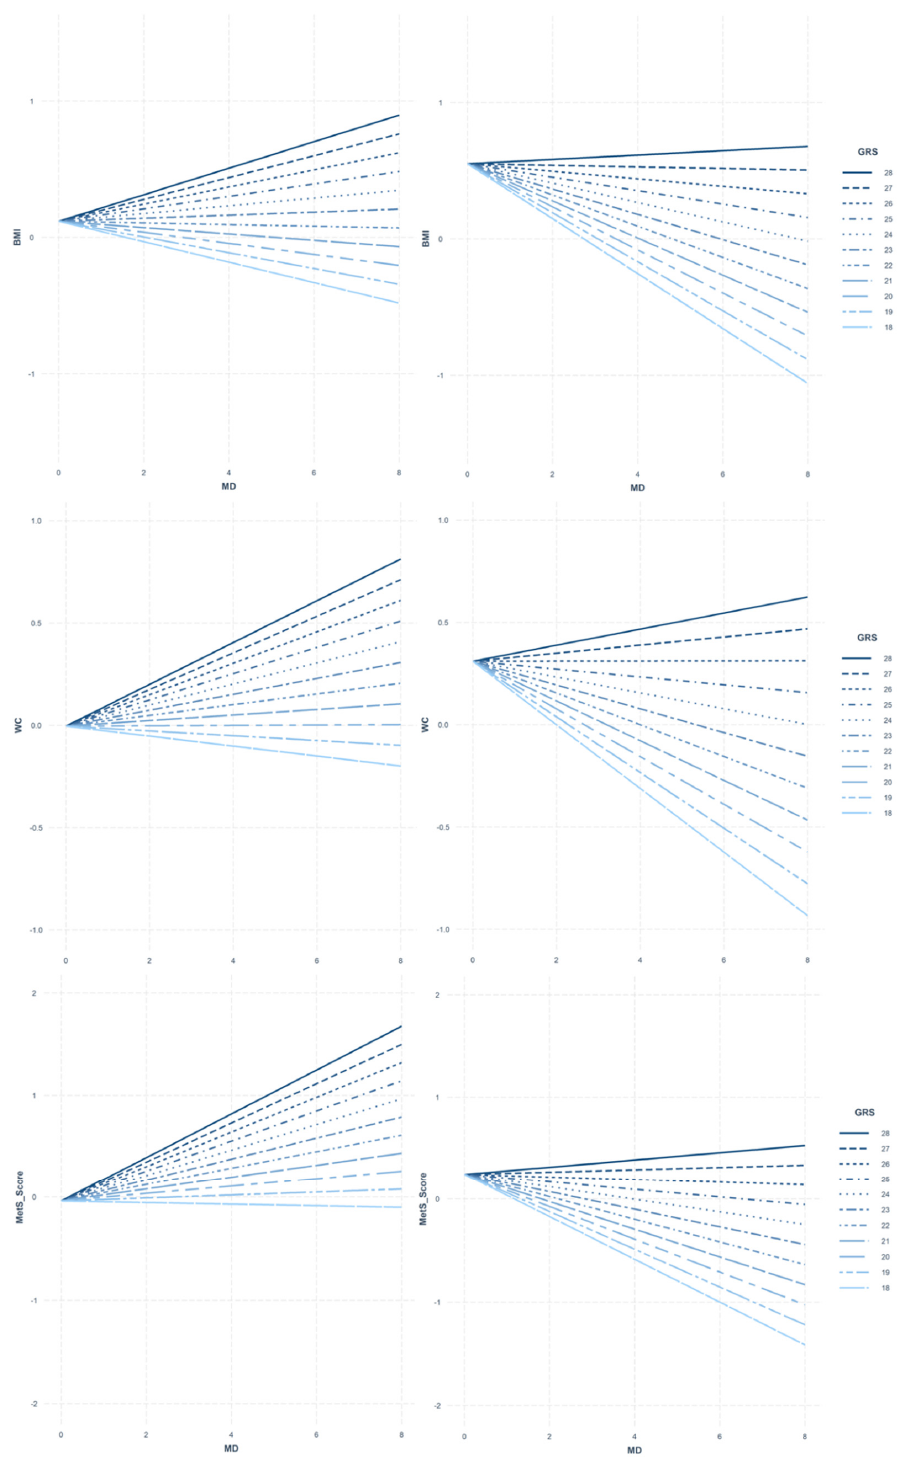
Figure 2. Interaction models between body mass index (BMI), waist circumference (WC), and metabolic syndrome score (MetS Score) and the Mediterranean diet (MD) according to the obesity genetic risk score (Obesity-GRS) modulation compared by gender (males left panel, females right panel). The Obesity-GRS values (18–28) are displayed according to our population distribution. Legend: The population distribution design follows different line patterns with reference points to observe the trend of the adolescent cohort according to the genetic risk for obesity. To analyze these results represented in the figure, a positive gradient shows the MD acting as arisk factor, while a negative gradient shows the protective role of the